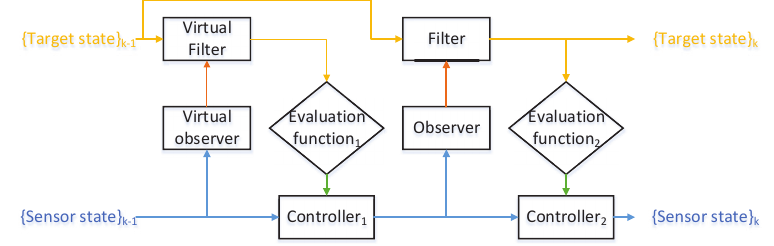
Figure 3. The proposed sensor control